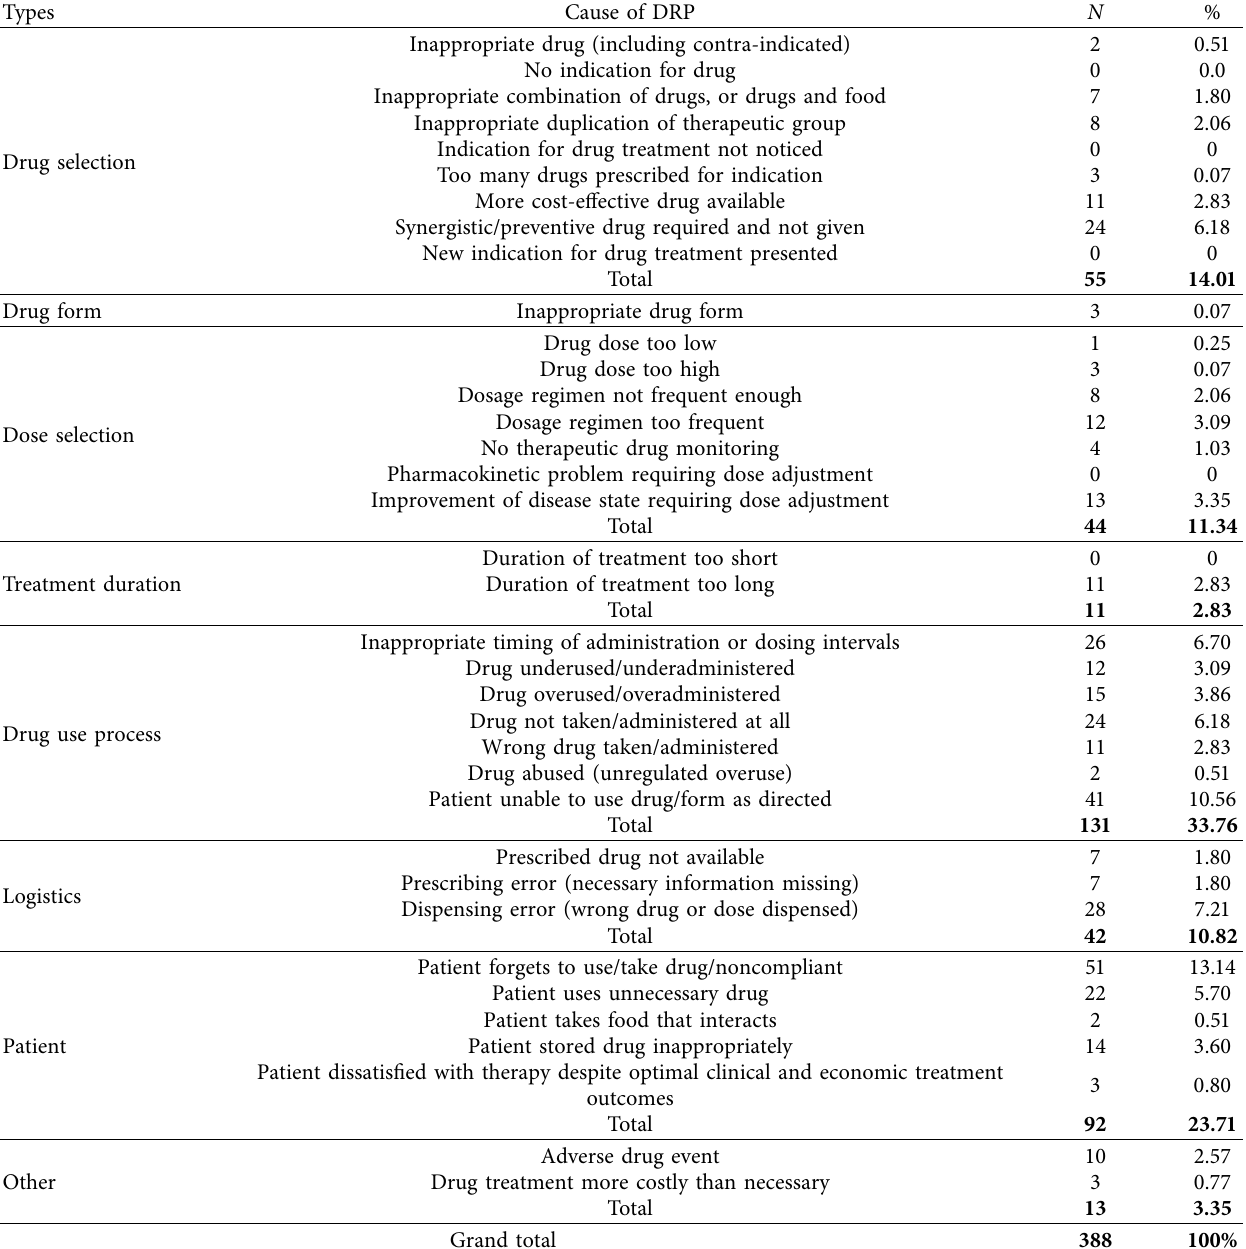
Table 3: Cause of DRPs as per PCNE